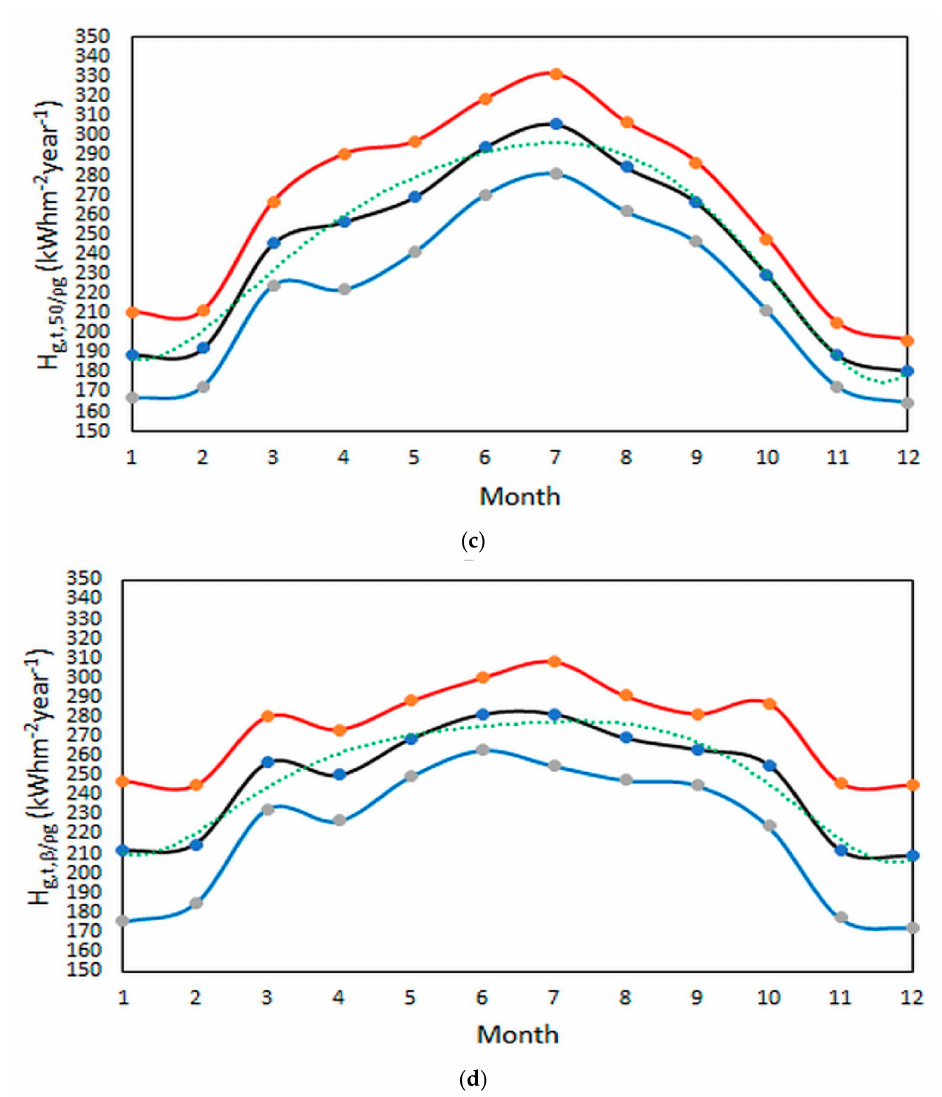
Figure 5. Intra-annual variation of ( a ) H g,t,40/ ρ g in SEZ-A, ( b ) H g,t,45/ ρ g in SEZ-B, ( c ) H g,t,50/ ρ g in SEZ-C, and ( d ) H g,t, β / ρ g in all SEZs, under all-sky conditions and averaged over the period 2005–2016. The black solid lines represent the monthly H g sums averaged over all corresponding sites. The red lines correspond to the mean + 1 σ curves, and the blue lines to the mean − 1 σ curves. The green dotted lines refer to the best-fit curves to the mean